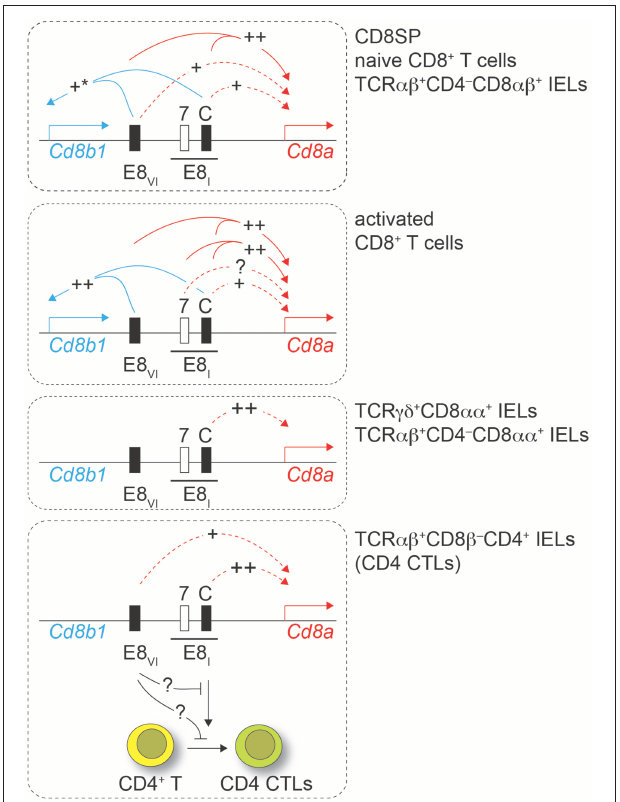
FIGURE 8 | Working model. Drawings depict the Cd8ab1 gene complex (not in scale) in various T cell subsets as depicted on the right. For simplicity, only E8 I and E8 VI are shown. The black bar above E8 I indicates the 7.6kb genomic region containing the core region of E8 I (C) and ECR-7 (7). Solid lines indicate synergy of E8 I -core and E8 VI as revealed by combined deletion of the respective regions, while dotted lines show the effect of the individual enhancer regions. “ ++ ” indicates a strong impact on Cd8 gene expression, while “ + ” indicates a moderate impact. “ + *” in the upper panel indicates a tendency that did not reach statistical significance. Lowest panel: loss of E8 I affects also the differentiation of CD4 + T cell into intestinal CD4 CTLs, which is partially reverted upon additional loss of E8 VI . See text for more